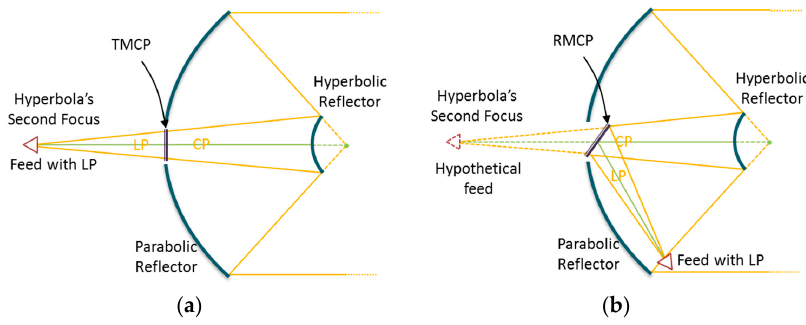
Figure 4. Schematics of Cassegrain antennas with ( a ) TMCP and ( b ) RMCP.